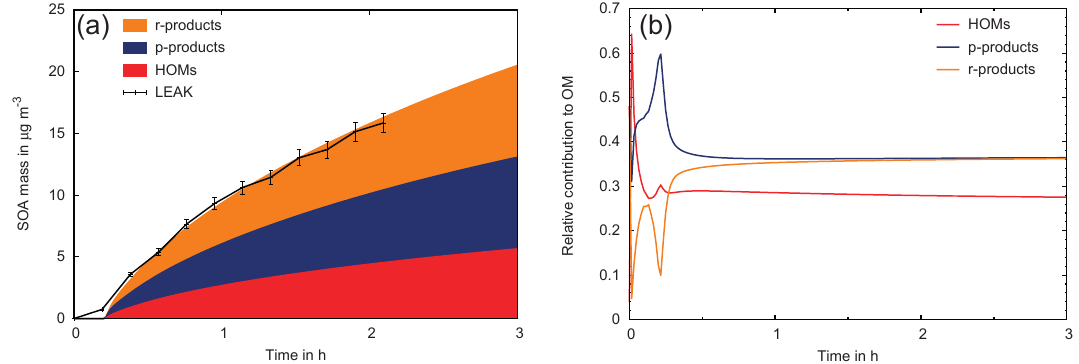
Figure 10. (a) Simulated SOA mass as shown in Fig. 8b for k b = 10 − 2 s − 1 resolved for the different components and compared with aerosol chamber measurements from LEAK. (b) Relative contribution of the individual product classes to the total organic mass.